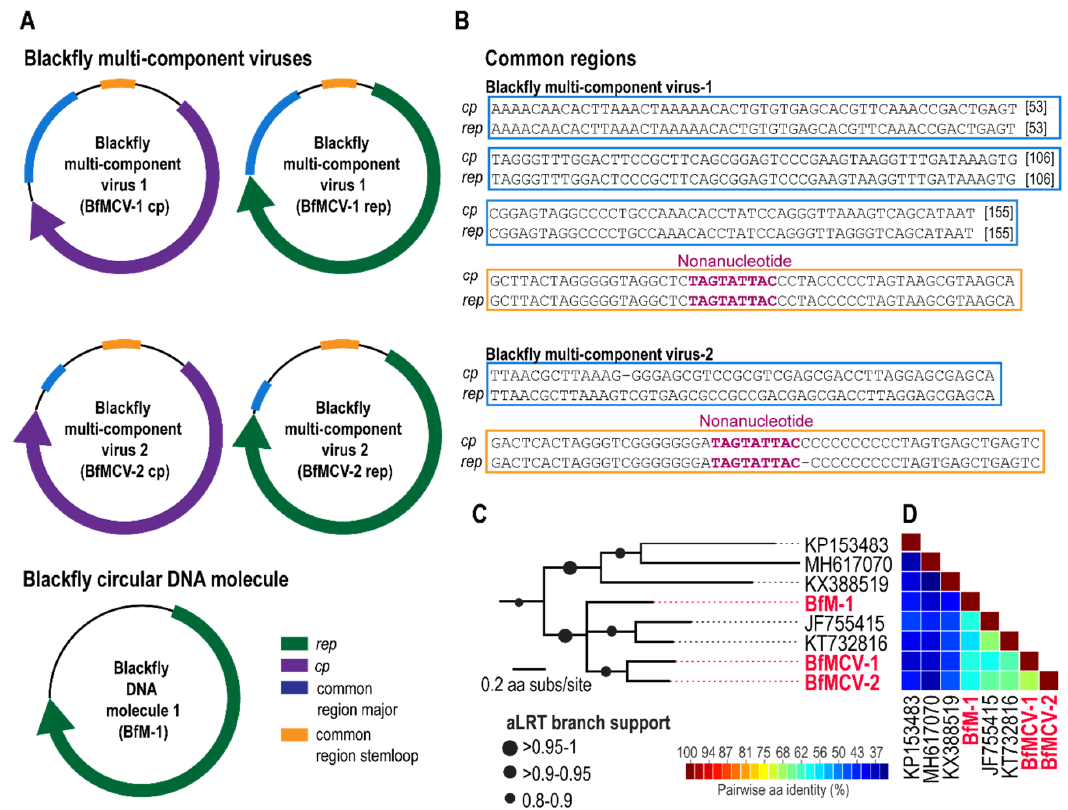
Figure 3. ( A ) Genome organisation of two blackfly multicomponent DNA viruses (1 and 2) and a DNA molecule indicating open reading frames and common regions ( B ) Alignment of the common regions from blackfly multicomponent virus 1 and 2 ( C ) Phylogeny of Rep for the two multicomponent viruses, DNA molecule and closest relatives ( D ) Pairwise comparison of the Reps show percentage similarity.